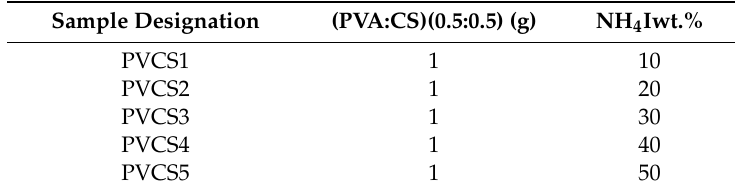
Table 1. Designation and composition of the various PVA:CS:NH 4 I solid polymer electrolytes